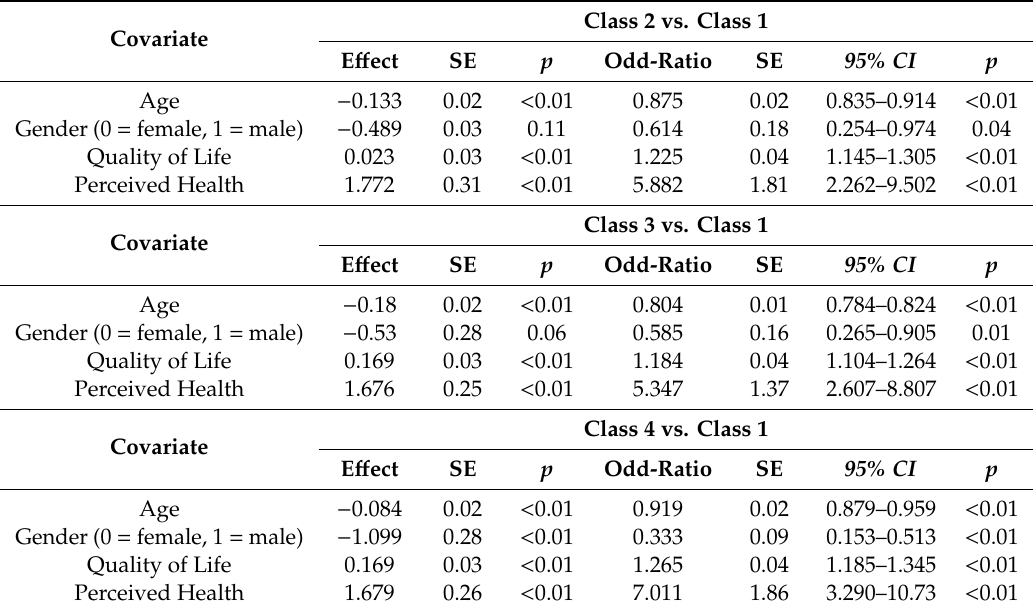
Figure 1. Conditional probabilities of symptoms depending on the class. Table 4. Effects, standard errors, odds-ratio, confidence intervals and significance tests for all covariates in the model with class 1 as the reference group.